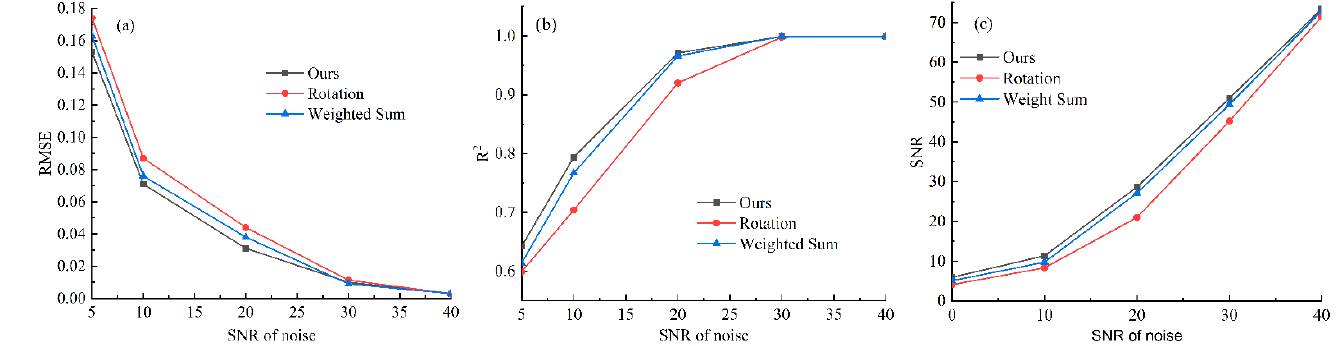
Figure 11. The quantitative denoising result with different data augmentation methods. ( a ) RMSE; ( b ) R 2 ; ( c ) SNR.